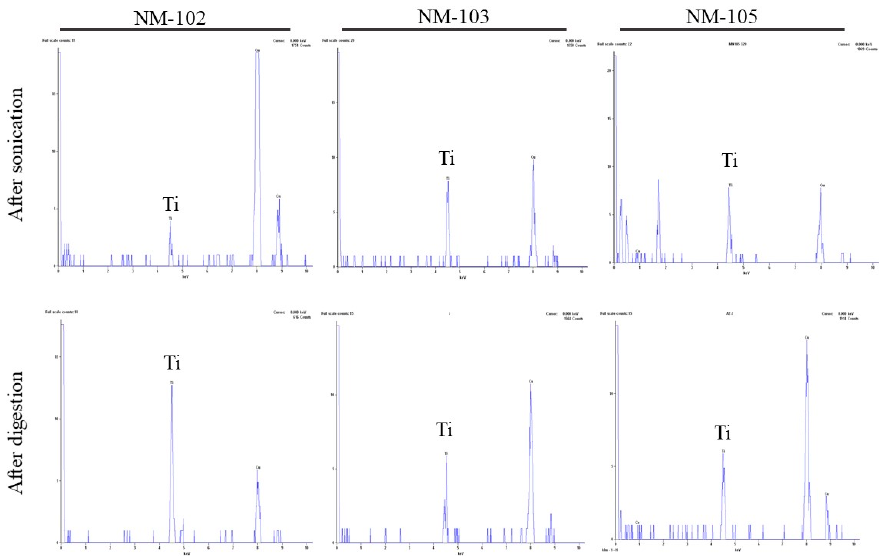
Figure 2. TiO 2 observed under electron microscopy, at a scale of 200 nm.